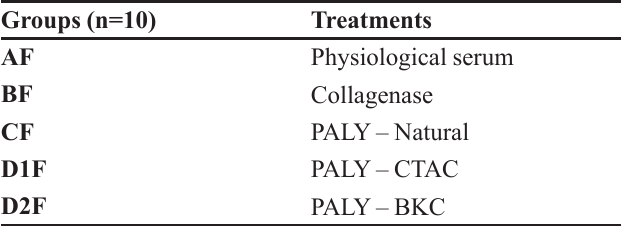
TABLE I - Distribution of experimental groups for evaluation of skin wounds in